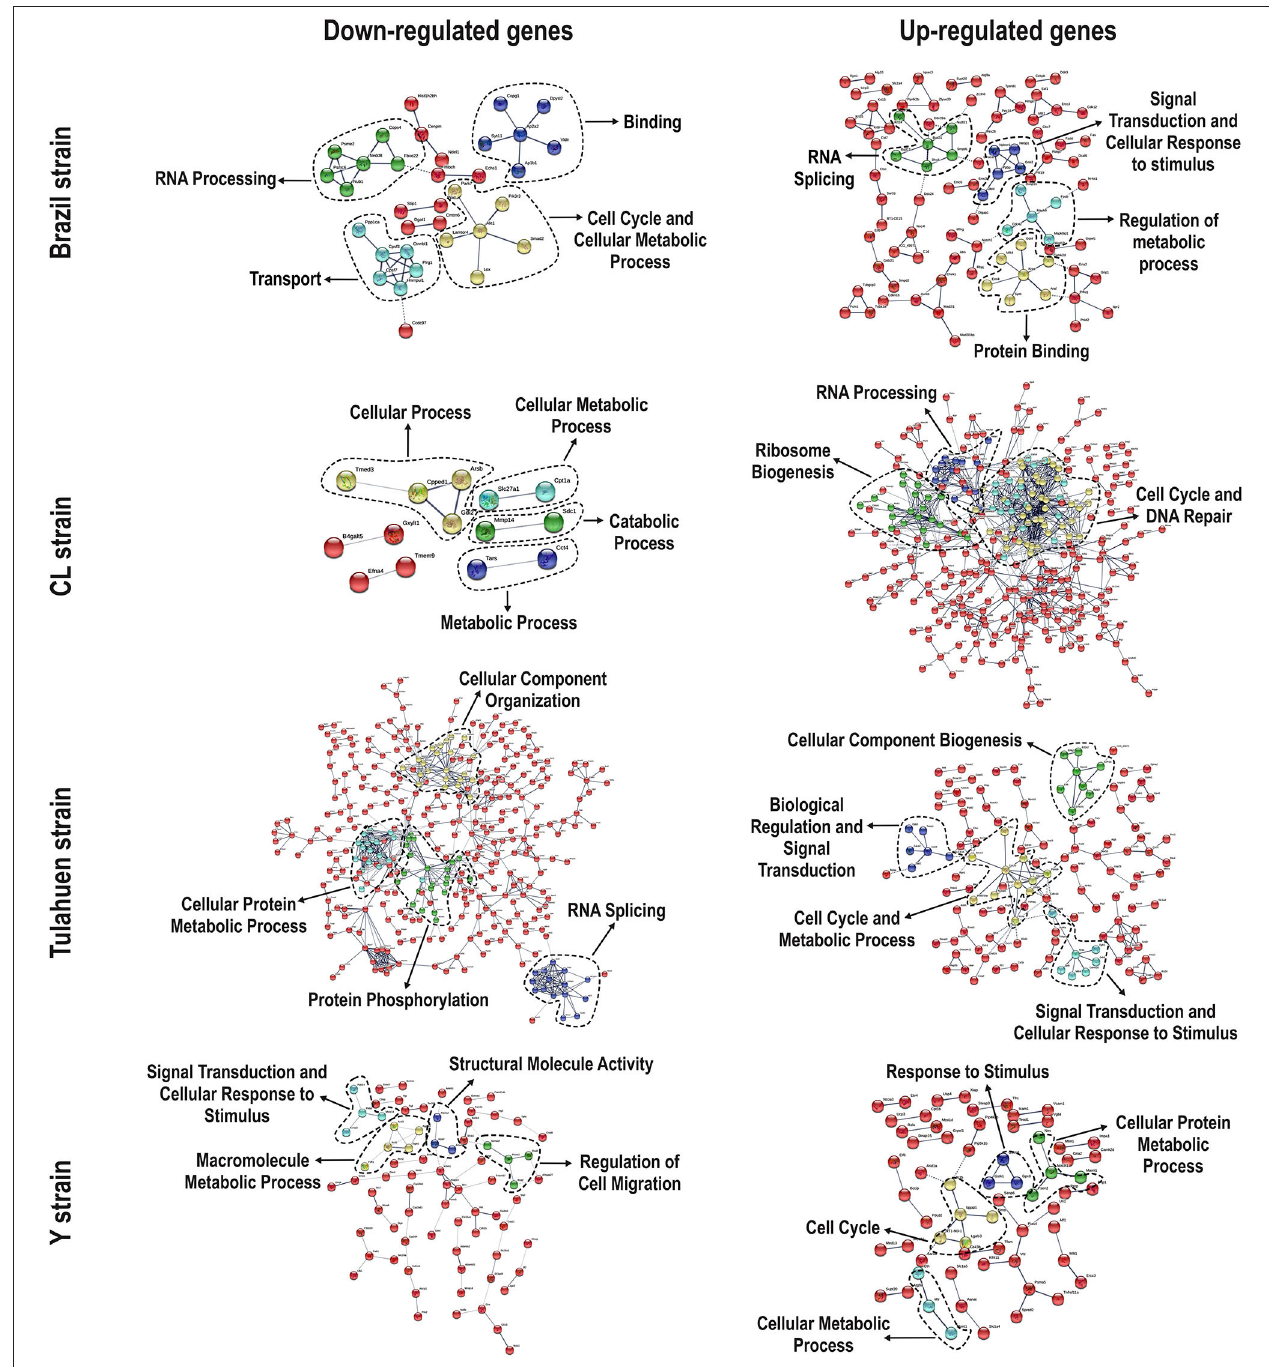
FIGURE 1 | Protein–protein interaction (PPI) networks revealed by upregulated and downregulated genes after infection with each Trypanosoma cruzi strain. Among the downregulated ( left panels) and upregulated genes ( right panels), we obtained/assembled PPIs using STRING software, with a confidence cut-off that ranged from 0.4 to 0.7. Nodes labeled with the encoding gene symbol indicate proteins, and the lines represent the corresponding interactions. The confidence score of each interaction is mapped to the line thickness (the thicker the line, the more evidence to support the interaction). The network was then enriched according to a gene ontology database. Subsequent analysis with K-means algorithm predicted nodes of interacting proteins (highlighted with the dashed lines), and such nodes were determined with Pathvisio assigning their molecular functions.